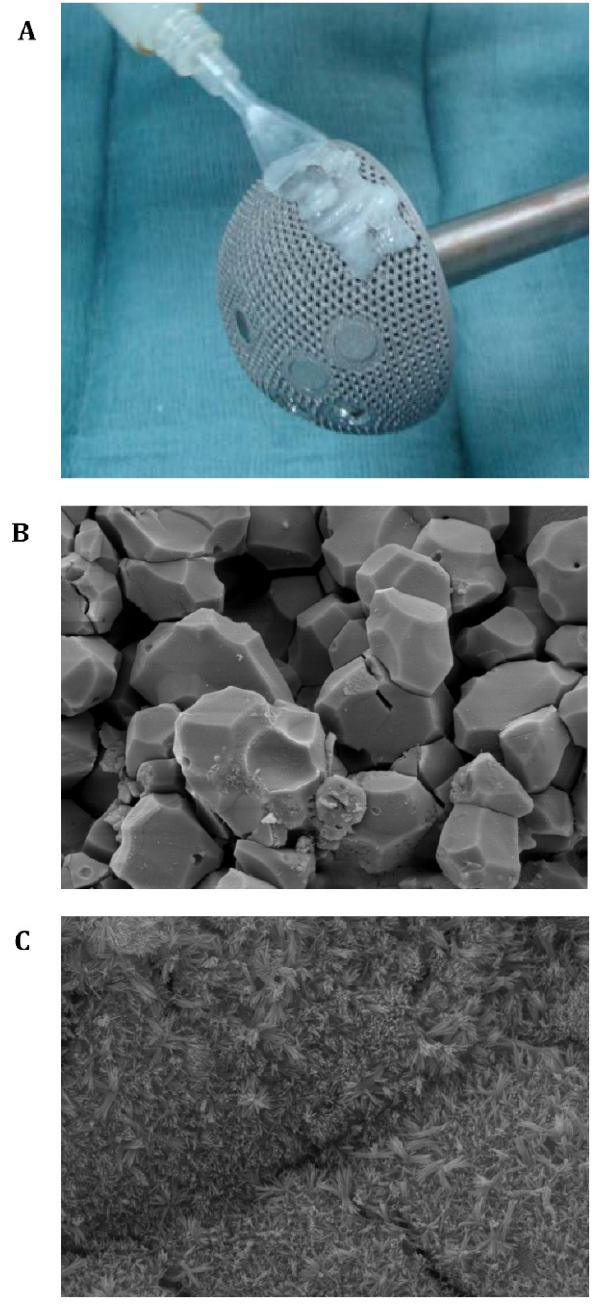
Figure 1. DAC ® hydrogel application on a titanium acetabular cup prosthesis (A). The hydrogel comes in powder form in a prefilled syringe and is designed to be reconstituted at the time of surgery with water for injection. Scanning Electron Microscope (SEM) analysis of sandblasted titanium samples surface (magnification 10,000x) without the hydrogel coating (B) or after DAC ® coating (C) and mechanical scraping of the hydrogel to test its ability to resist press-fit insertion. Note the complete and uniform coverage of the titanium